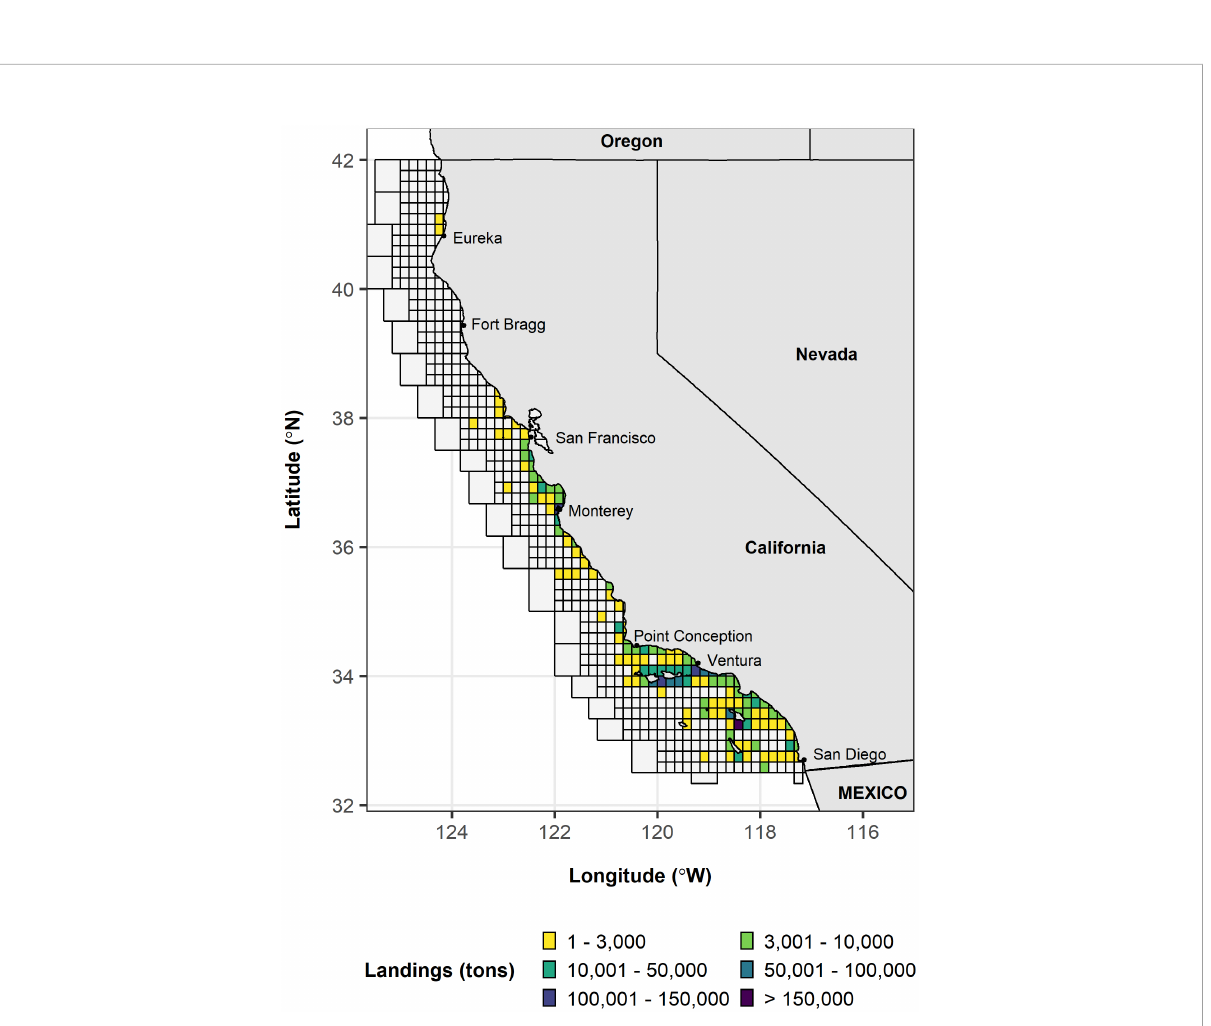
FIGURE 2 Map of total California commercial market squid fi shery landings (tons) by fi shing block from 1996 to 2018 fi shing seasons (CDFW MLDS). Fishing blocks with less than 15 entries were excluded.